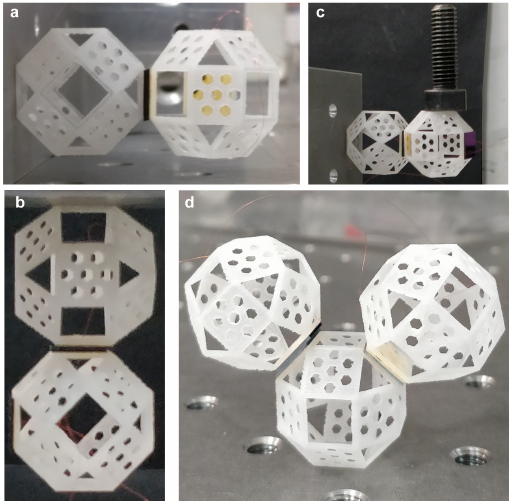
Figure 12. Experimental validation of different catom’s configurations. ( a ) Catom latching in overhang configuration (Case B). ( b ) Catom latching in vertical configuration (Case A). ( c ) Catom latching